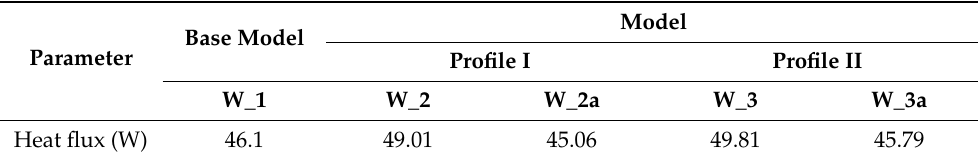
Table 6. Heat flux in the analysed 3D connection for all tested cases.